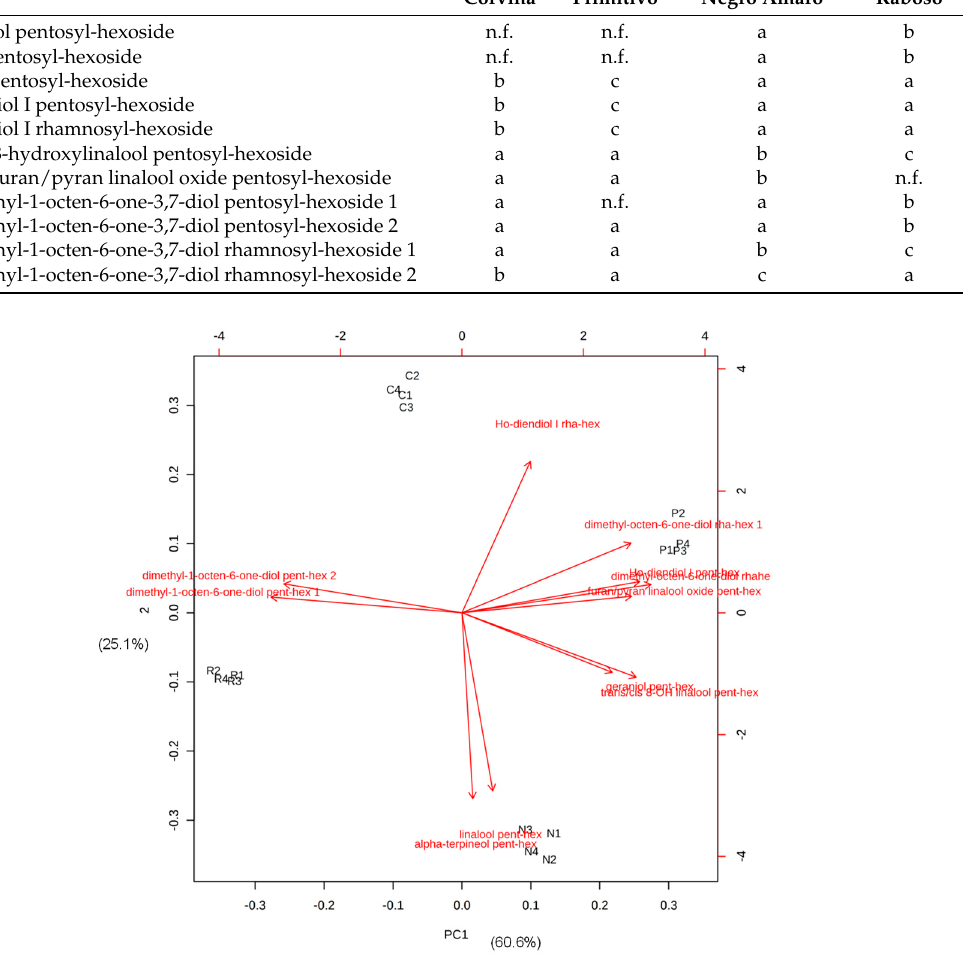
Figure 5. Biplot of the normalized UHPLC-Q/TOF signal intensities of monoterpene glycosides identified in the four varieties studied. P: Primitivo, C: Corvina, N: Negro Amaro, R: Raboso Piave. Pent-hex, pentosyl-hexoside; rha-hex, rhamnosyl-hexoside.